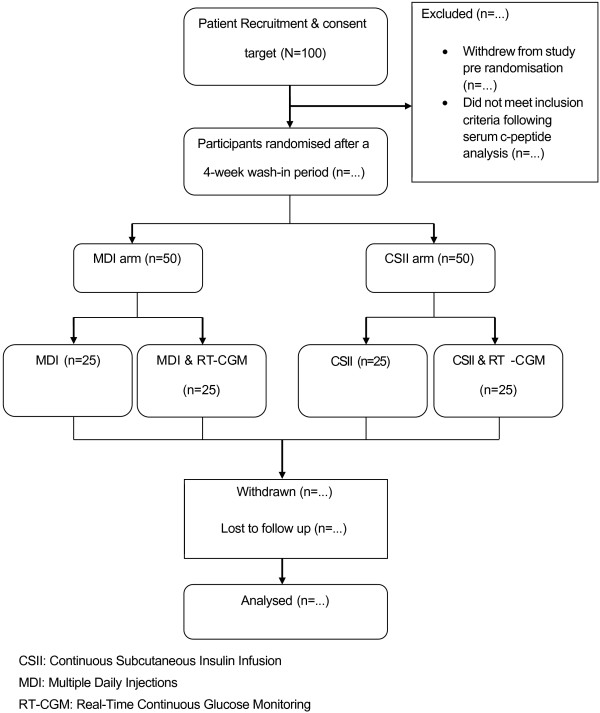
Proposed flow through RCT.